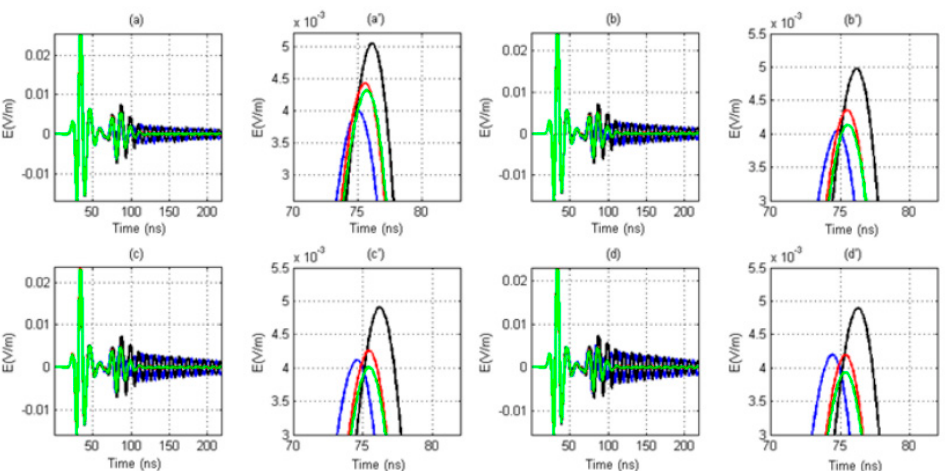
Figure 7. Received signals of the four receiving antennas (blue: the east antenna; black: the west antenna; red: the south antenna, green: the north antenna) for different array diameters. ( a ) 4 cm, ( b ) 5 cm, ( c ) 6 cm, ( d ) 7 cm. ( a’ – d’ ) Local amplification for corresponding figures ( a – d ).